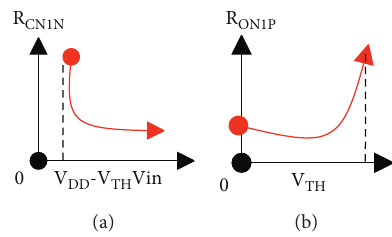
Figure 4: The relationship between the on-resistance of MOS and the input voltage.